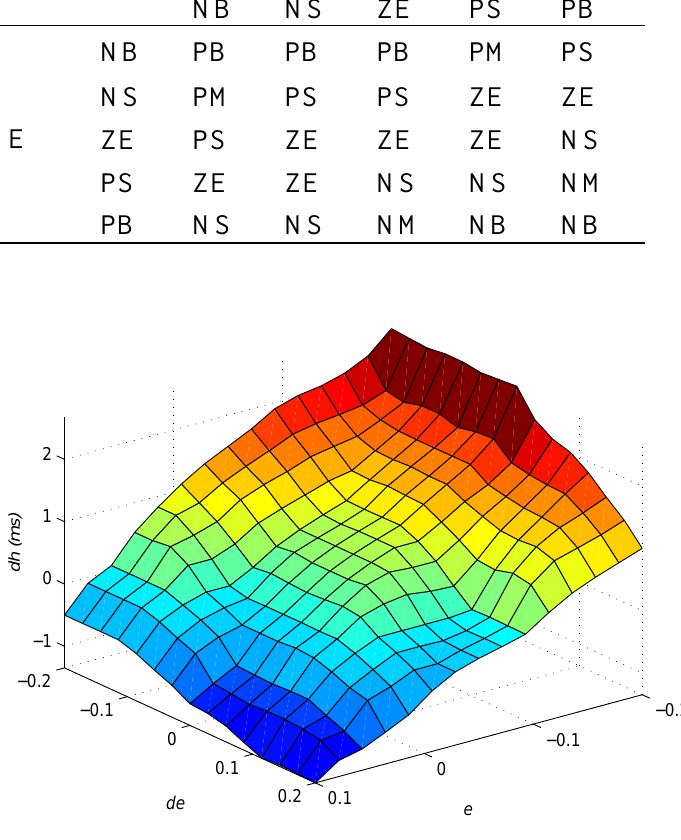
Figure 5. Input-output